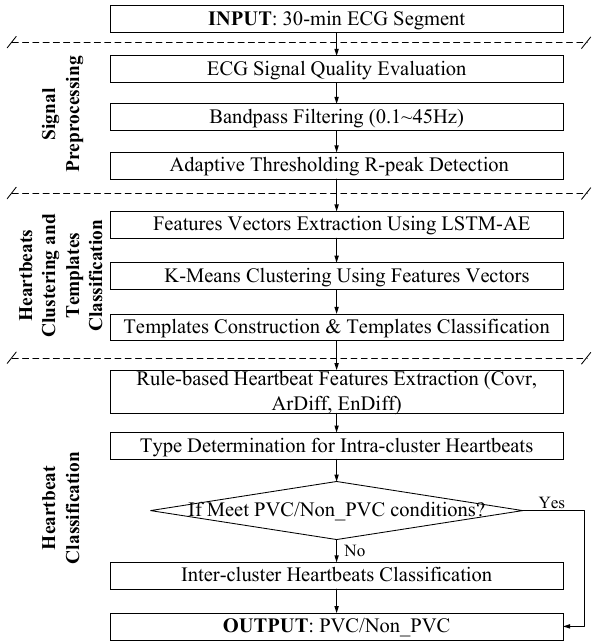
Figure 1. Flowchart of proposed method.